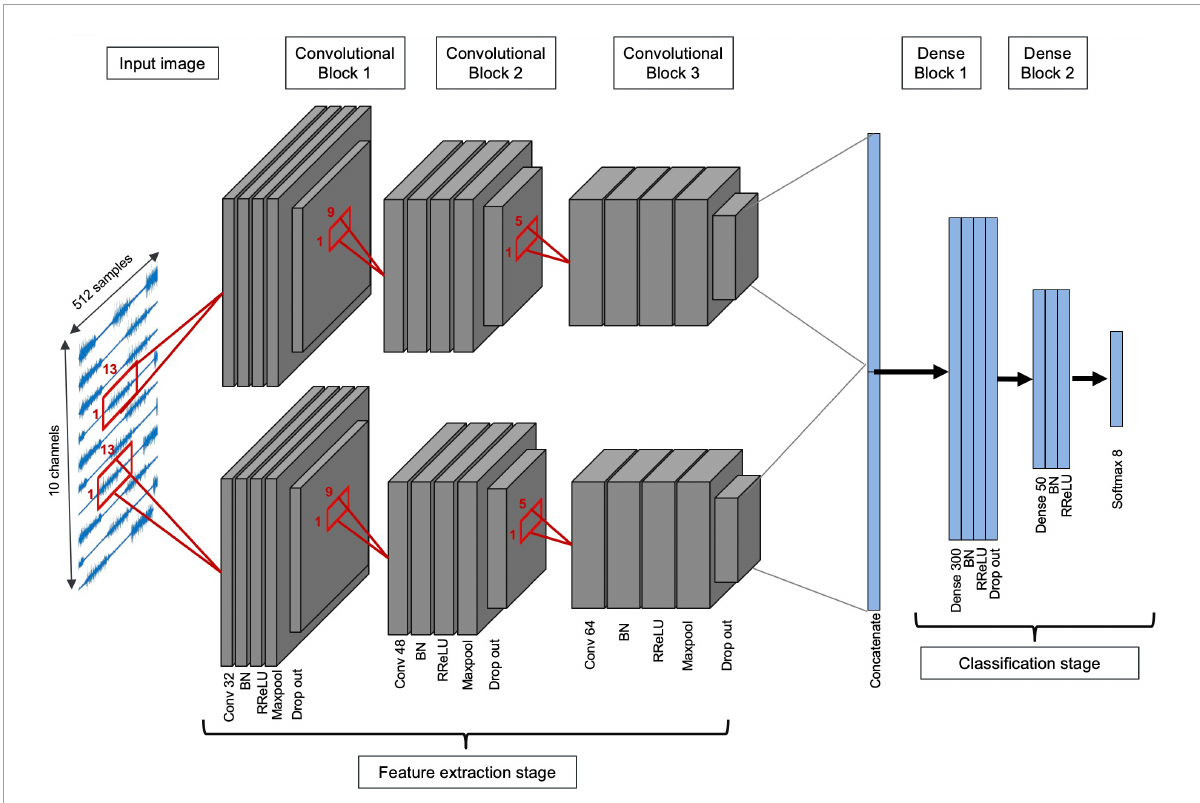
FIGURE4 Architecture of the proposed transfer learning method with Cnet1D as base model. The gray layers are pre-trained (top blocks are pre-trained with target subject data, and lower blocks are pre-trained with data from all other subjects), and their parameters will be frozen while the blue layers are trained with the target subject database. Thus, in the process of the proposed transfer learning method, target subject’s data is used two times at two different